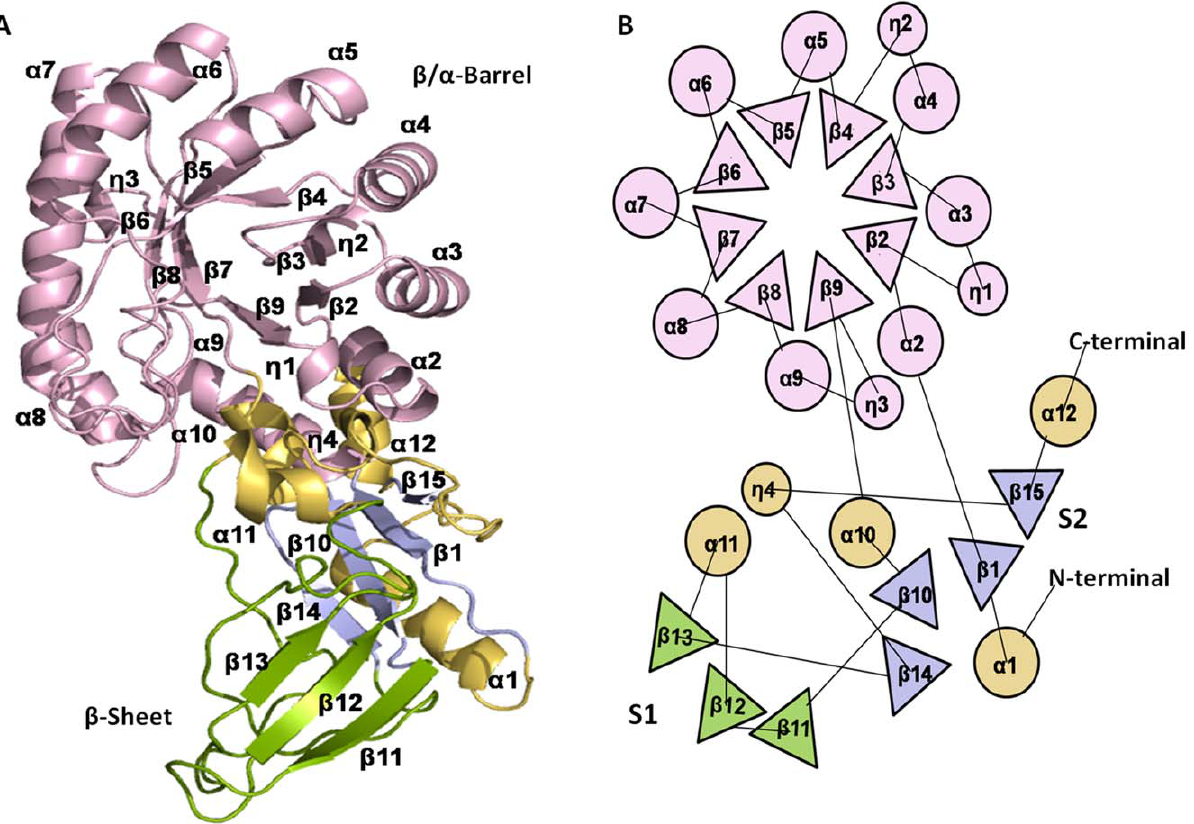
Figure 8. 3D structure of Eh ODC monomer. (A) Cartoon diagram of Eh ODC model generated using Modeller 9v8. (B) Topological arrangement of secondary structures in Eh ODC monomer. Monomer of Eh ODC consists of two domains, b / a -barrel shown in purple and sheet domain having sheet S1 in green, sheet S2 in blue and helices and turns in orange. The helices are presented by circles, strands are represented by triangles and the loops connecting these structures are represented as connecting